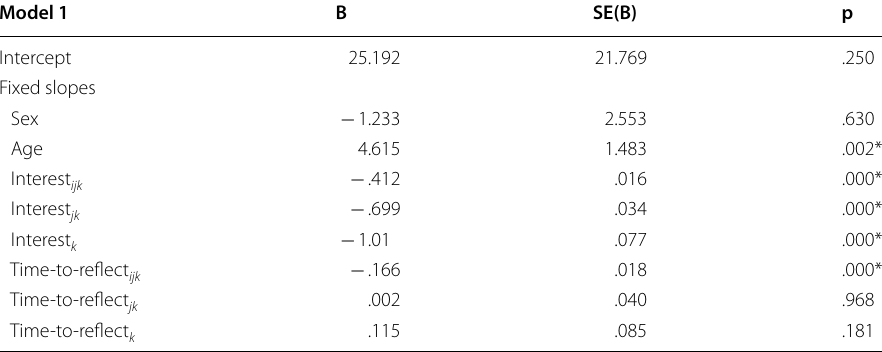
Table 3 Main effects of control and value